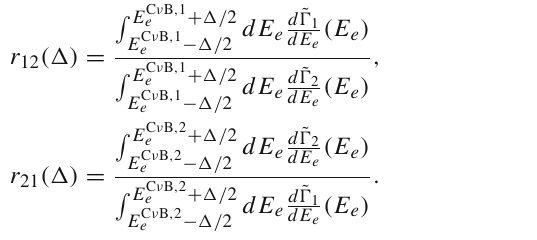
and δ f c ν since we only estimate the leading order of the required i i